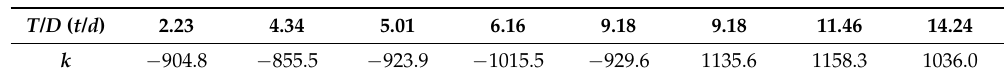
Table 2. k for different t / d